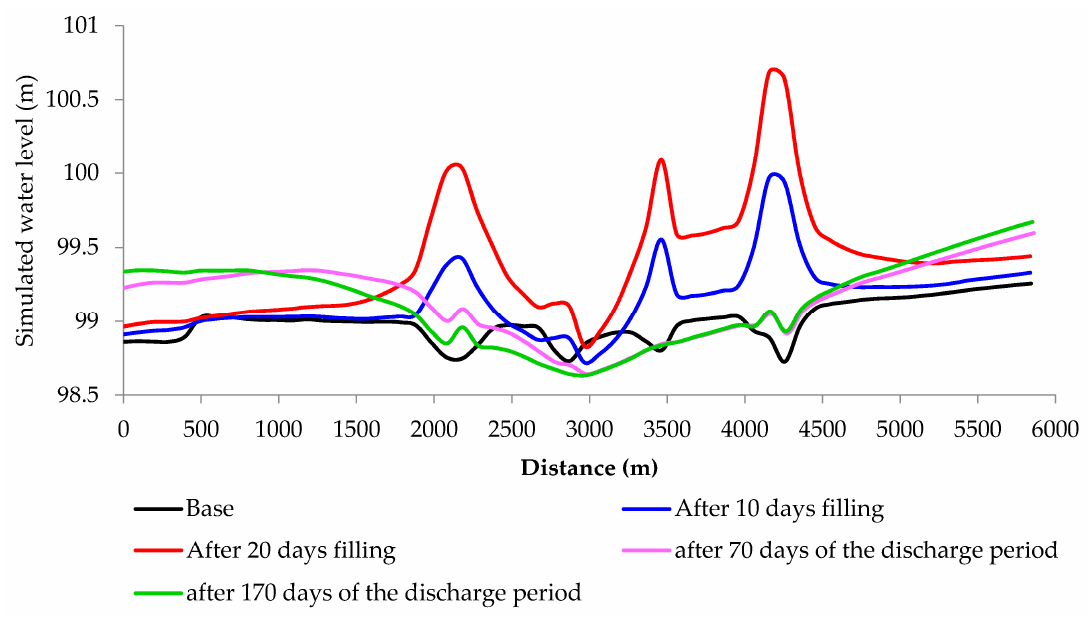
Figure 10. Simulated groundwater levels at a line crossing the Lake Korcsina at 10 and 20 days of filling and at 70 and 170 days of discharge period with respect to the base case.